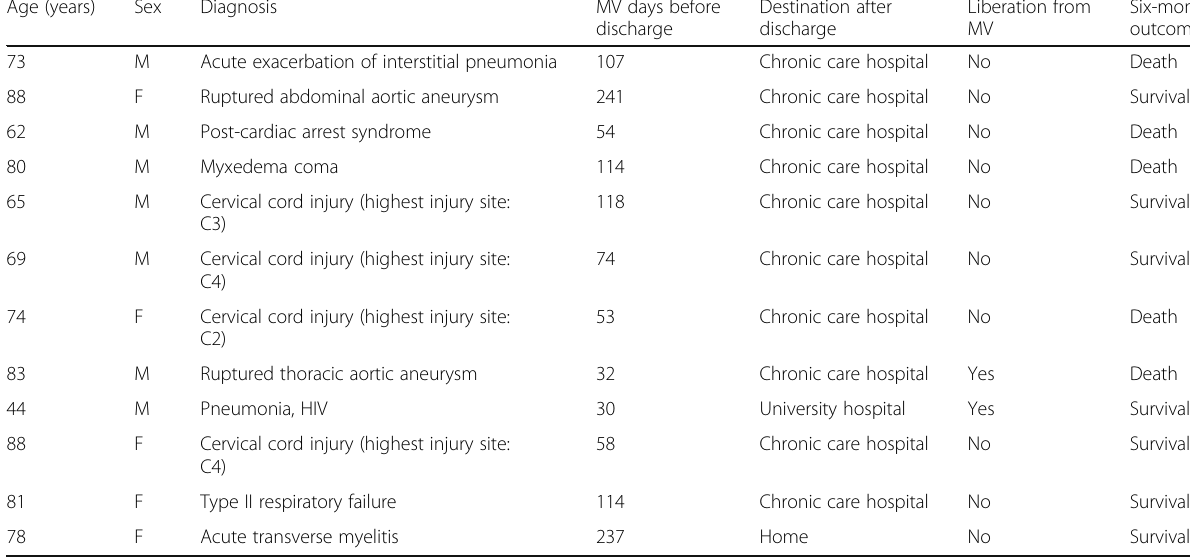
Table 3 Outcomes at 6 months after discharge of 12 patients who required mechanical ventilation at